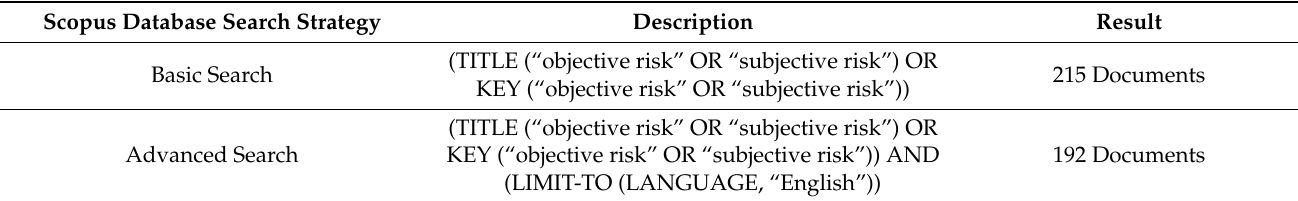
Table 2. Basic and advanced search